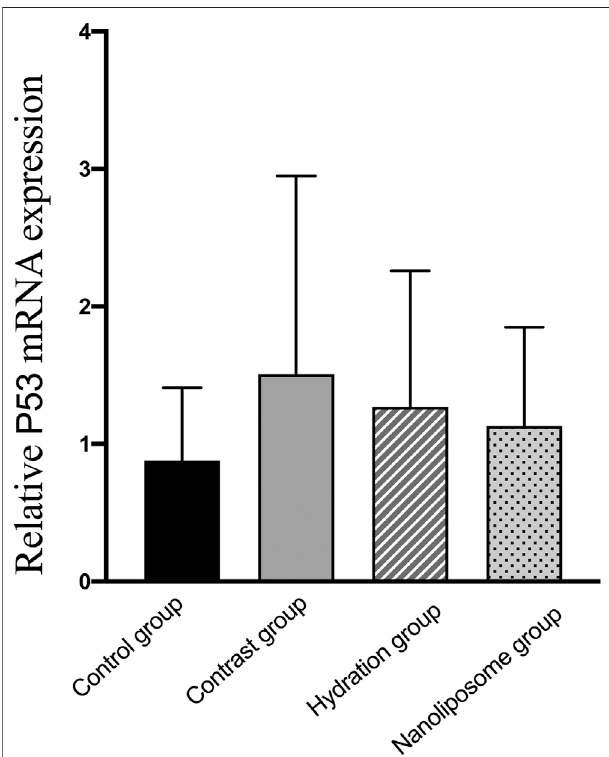
FIGURE13| TherelativemRNAexpressionoftargetgenewasdetected by Real-time PCR. Real-time PCR was used to validate the change in the expression of the P53 gene identi fi ed in four groups. P53: a apoptosis inducing factor. Values are expressed as mean ± SD. *Compared with the contrast group, p < 0.05. **Compared with the contrast group, p < 0.01. # Comparedwiththehydrationgroup, p < 0.05. ## Compared withthehydration group, p <